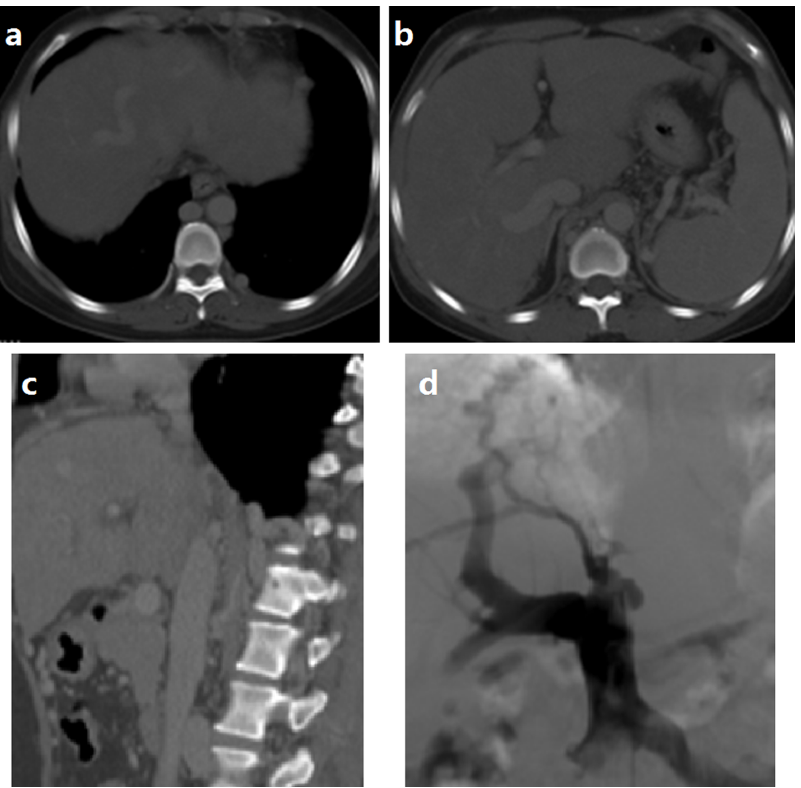
Figure 4. The CTA images of portal venous phase and DSA image during intervention. The middle HV is obstructed, the right and left HVs are completely obstructed (Figure 4 a); The right, rear and inferior HVs are expanded (Figure 4 b), and the segmental IVC is obstructed (Figure 4 c); DSA image shows a segmental obstruction of the inferior caval vein, and intrahepatic collateral circulation for drainage of HV flows (Figure 4 d).